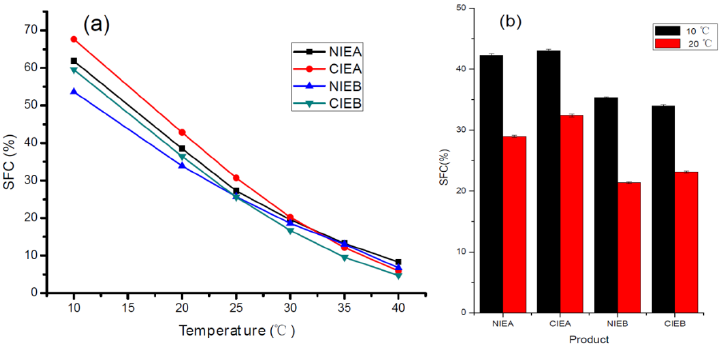
Figure 1. SFC of four fat blends ( a ) and the SFC of four final sheet margarine at 10 and 20 °C ( b